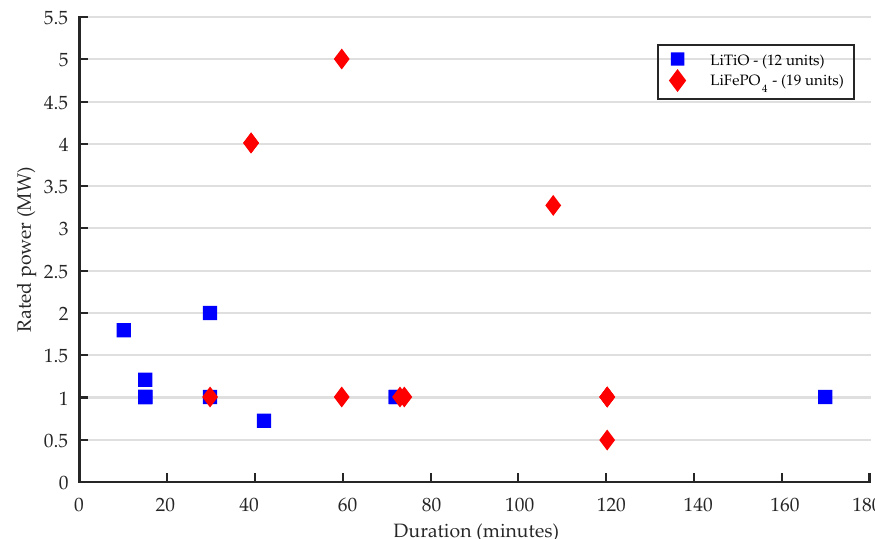
Figure 11. Li-ion battery technologies from 500 kW to 5 MW of power and 10 to 180 min of operating duration that are in operation worldwide [20].